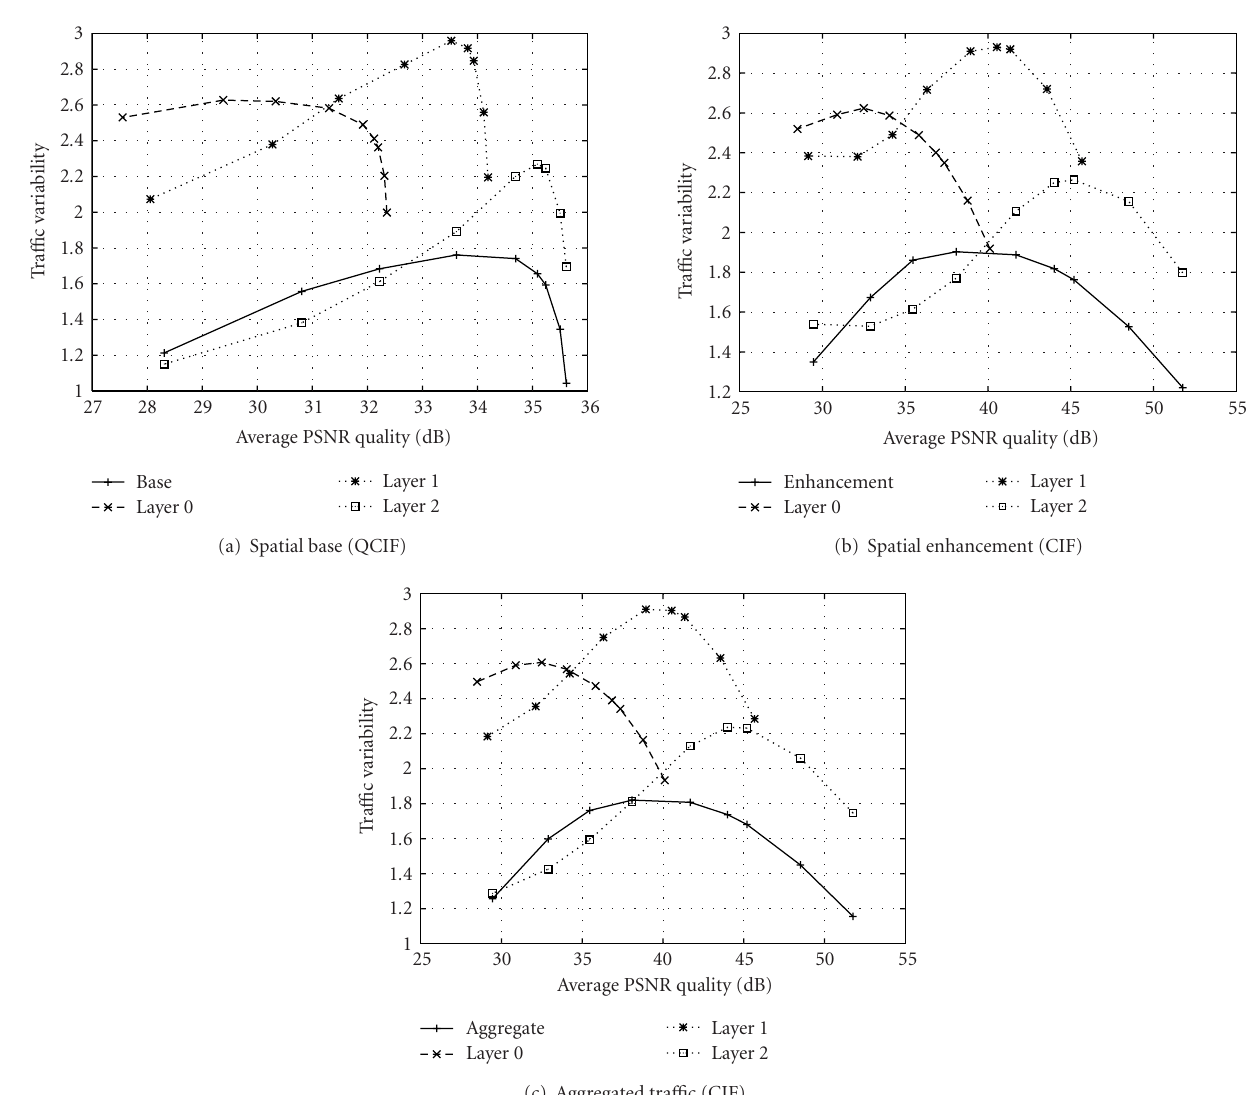
Figure 10: VD curves of all temporal layers ( 0 , 1 , 2 ) embedded in each spatial layer and in the aggregated (base + enhancement) tra ffi c stream, for the Star Wars IV sequence encoded with H.264 SVC ( G16-B3